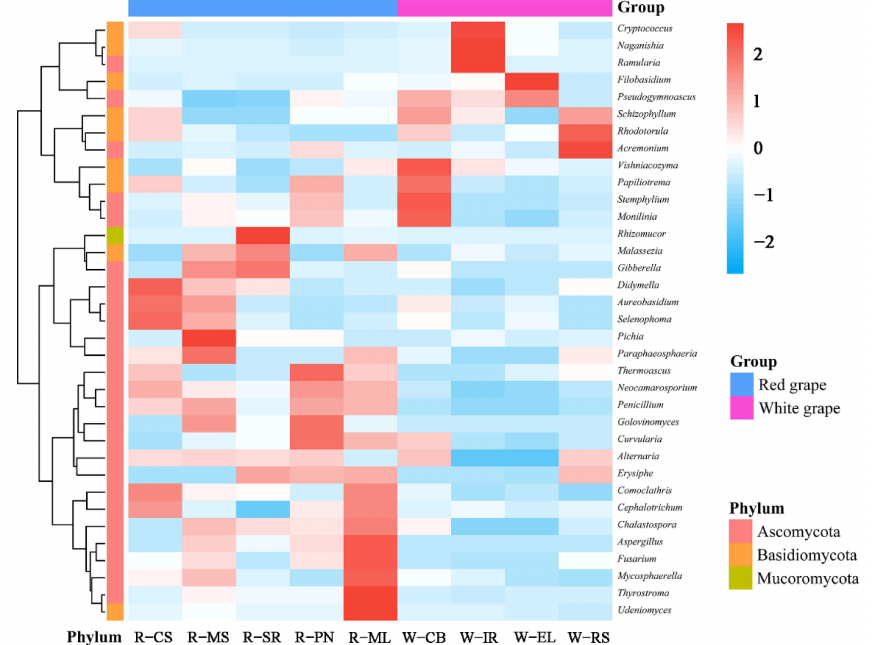
Figure 5. Heatmap of the top 35 abundant fungal genera in different grape samples. Samples are clustered according to the similarity between their constituents and arranged in horizontal order. Red and blue represent the more and less abundant genera in the corresponding group,